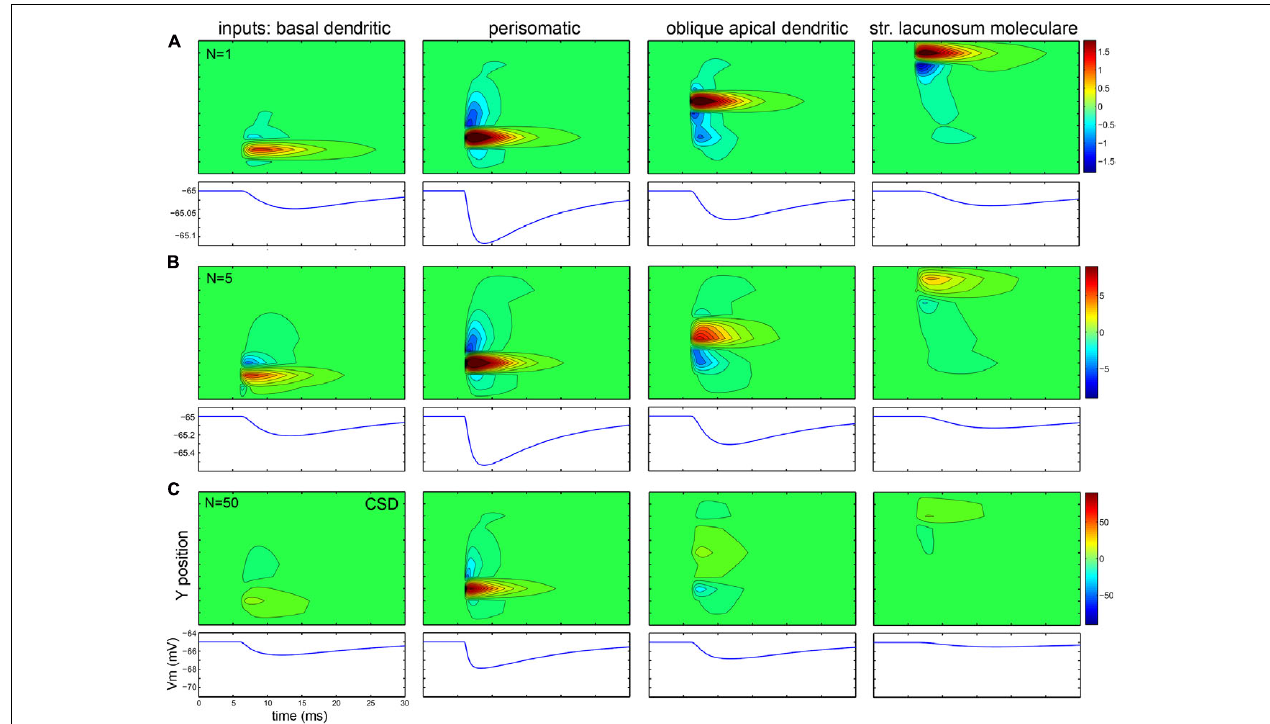
FIGURE 11 | While intracellular potentials sum, passive, and active extracellular currents cancel when many synaptic inputs are distributed over the dendrites. (A–C) Data are presented similarly to the previous figure, but here the top panel shows the CSD across the layers versus time, while the lower panel shows the change of membrane potential versus time. The amplitude, rise and decay time of the events change according to the rules of intracellular signal propagation (amplitude decreases, rise and decay time increases for more distal events). Multiple inputs sum intracellularly, but for inputs other than perisomatic ones, the extracellular signals tend to cancel when the number of inputs is increased, resulting in a much weaker signal. Numbers indicating color scales are in